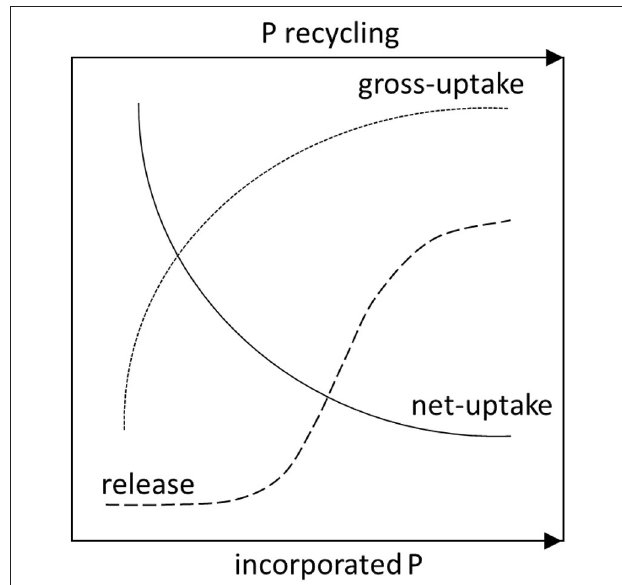
FIGURE 1 | The concept of phosphorus recycling based on the balance-scheme of phosphorus uptake by Elodea nuttallii (adapted from Angelstein, 2009): The measureable net-uptake and release (secretion) of phosphorus by E. nuttallii plants seems to depend on the phosphorus content in the plant tissue and the recycling of already released phosphorus. Thereby, a substantial phosphorus release (broken line) might first take place above a specific threshold of the incorporated phosphorus. The net-uptake rate (black line) of phosphorus decrease or become stable with increasing recycling and thus with an increase of phosphorus incorporated in the plant tissue. In parallel the gross-uptake rate (dotted line) might increase up to a specific level of incorporated phosphorus. The presented concept is a simplified scheme, and thus contains neither units, nor any